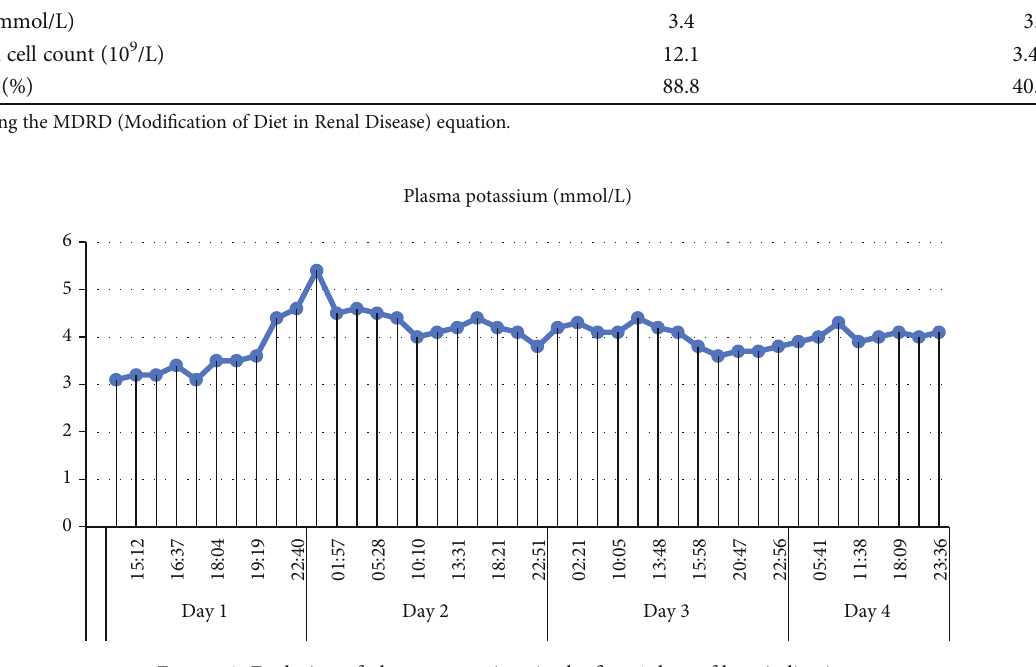
Figure 3: Evolution of plasma potassium in the fi rst 4 days of